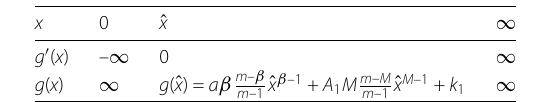
Table 1 Profile of g ( x